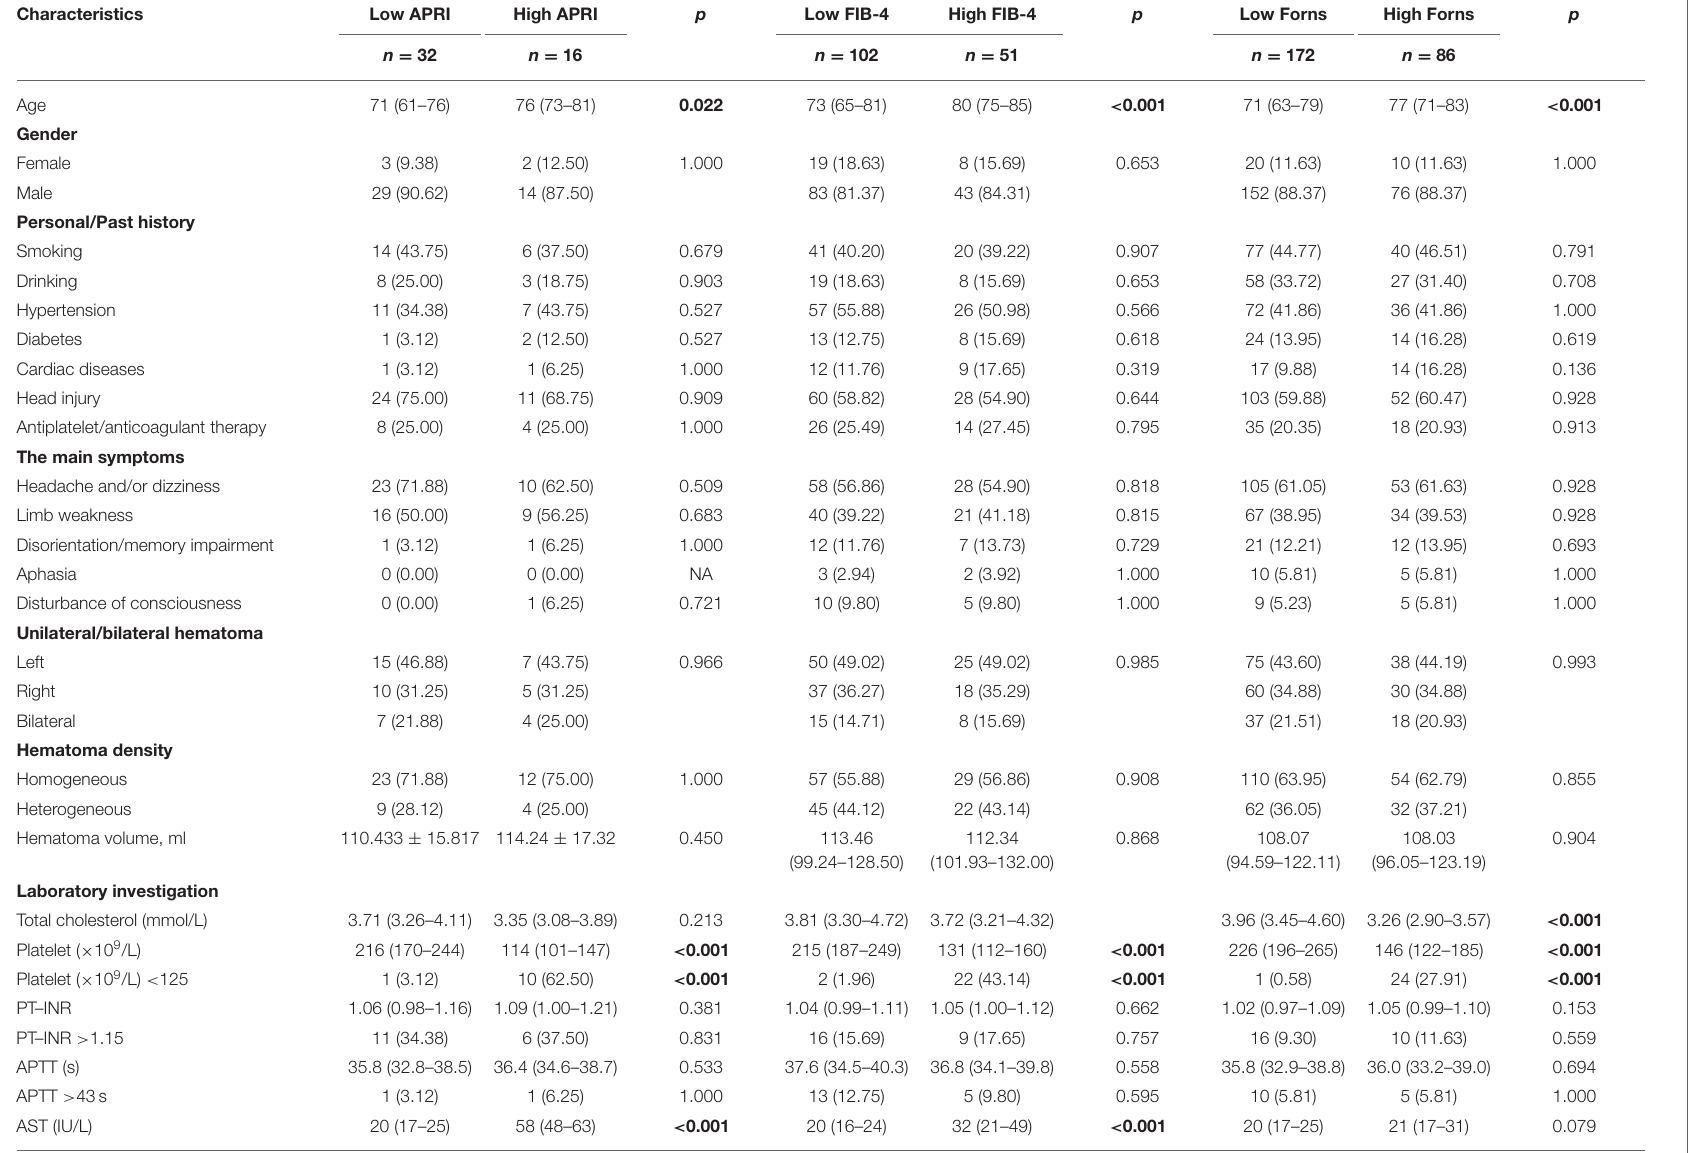
TABLE 2 | Baseline characteristics and outcomes of patients with CSDH, stratified by liver fibrosis scores after propensity score matching.